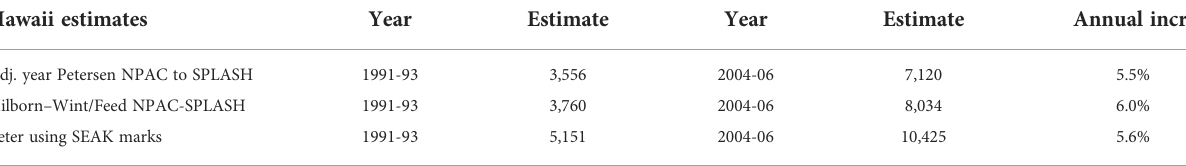
TABLE 2 Estimates of annual increases in humpback whale abundance based on comparison to previous estimates. Hawaii